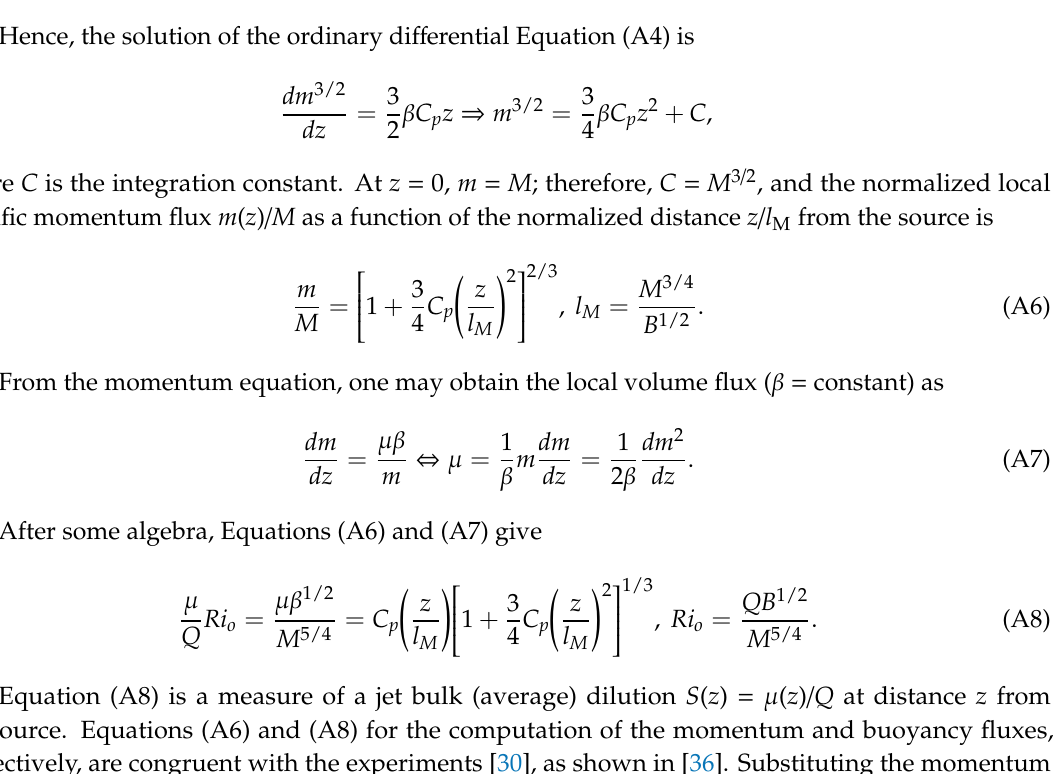
Figure A1. Buoyant jet width parameter plotted against the dimensionless elevation (data points from Papanicolaou and List